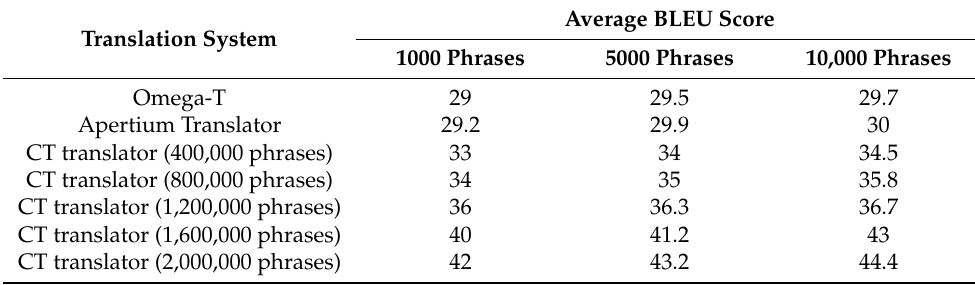
Table 5. Automated evaluation using F mean Score, for the English-Arabic